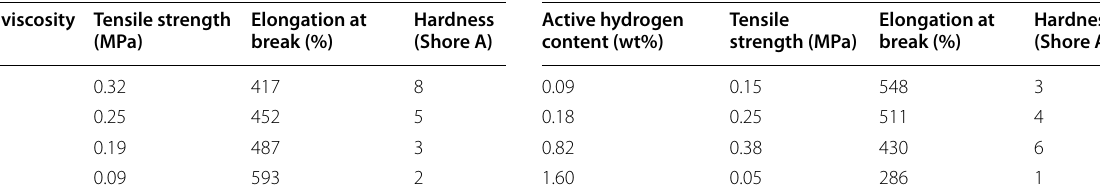
Table 2 Effect of Vi PDMS Vi viscosity on mechanical properties of PDMS polymer film